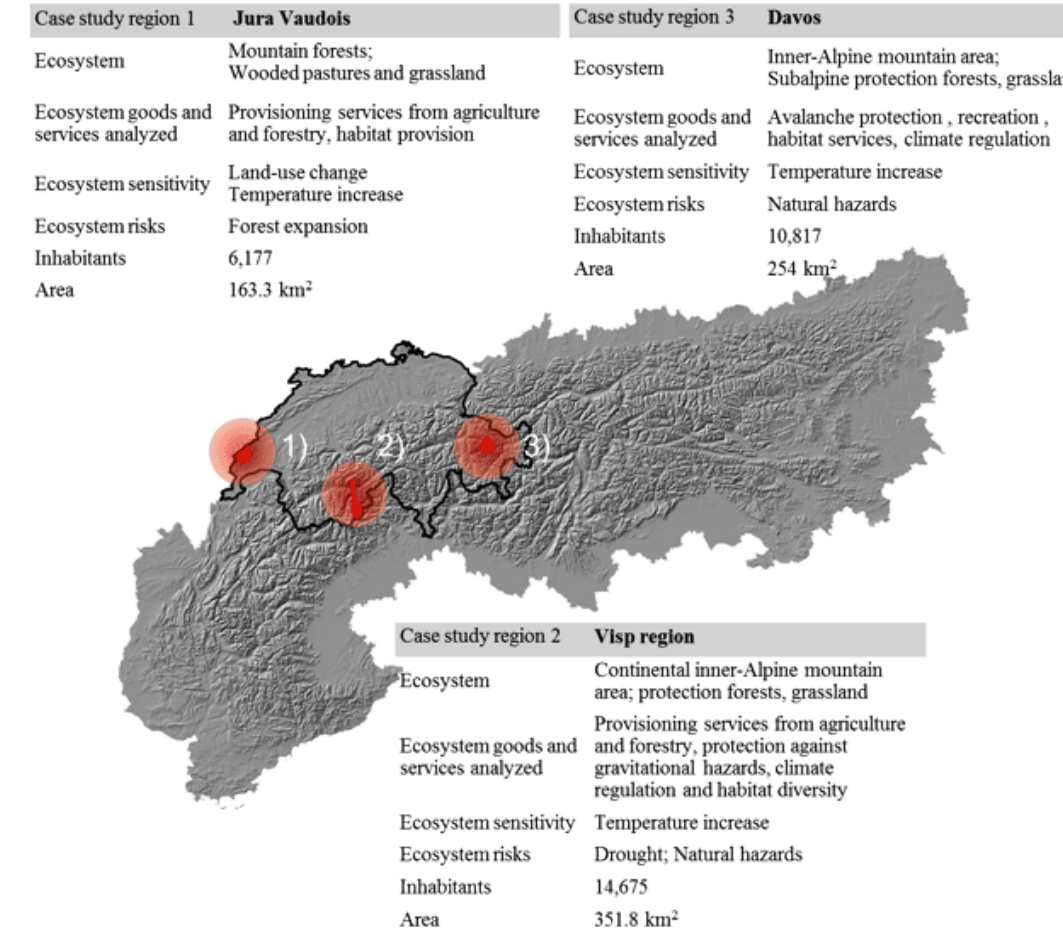
Fig. 1 . Map of the European Alps including location and characterization of the three MOUNTLAND case study regions. The spatial-explicit modeling focused on the core zone (dark red). The circular surfaces (brighter red, transparent) indicate the areas of application, including the locations of some of the plot- scale experiments (map produced by A. Psomonas,